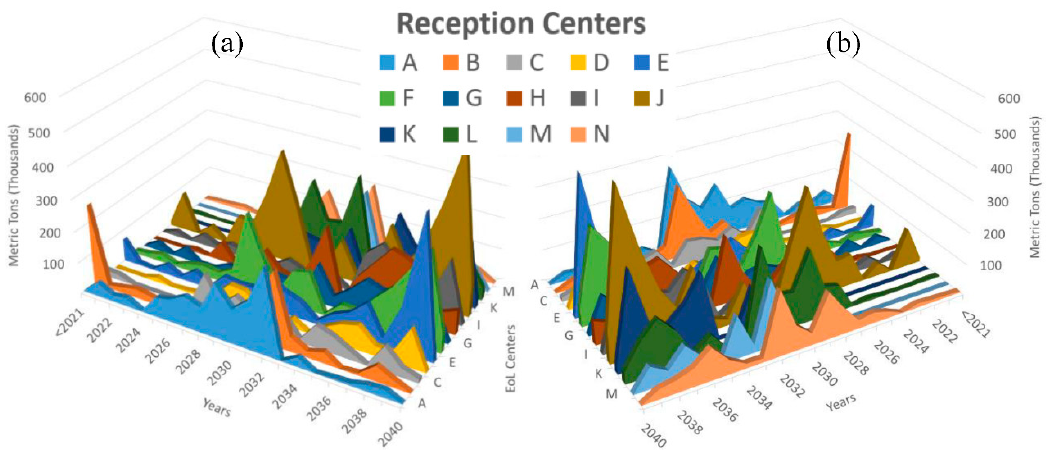
Figure 12. Performance of US—EoL centers over time considering decommissioning year from <2021 to 2040: ( a ) front view, ( b ) reverse view.